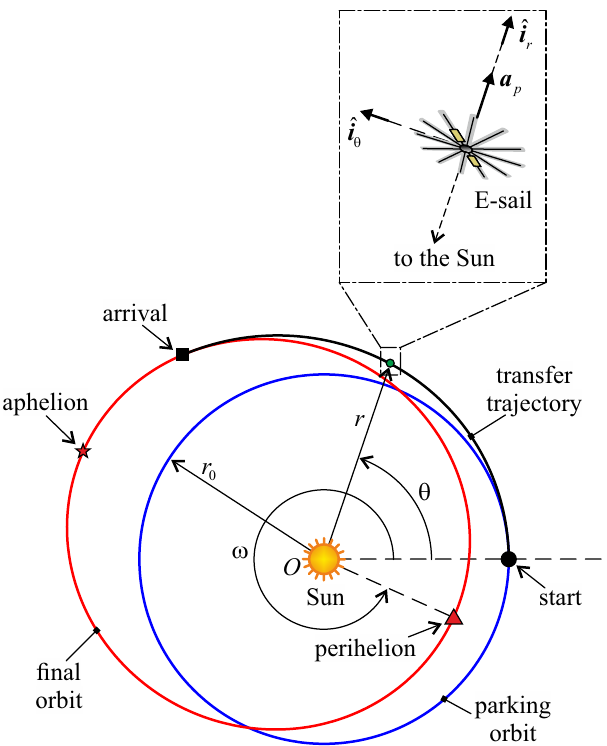
Figure 1. Reference frame and E-sail-based spacecraft state